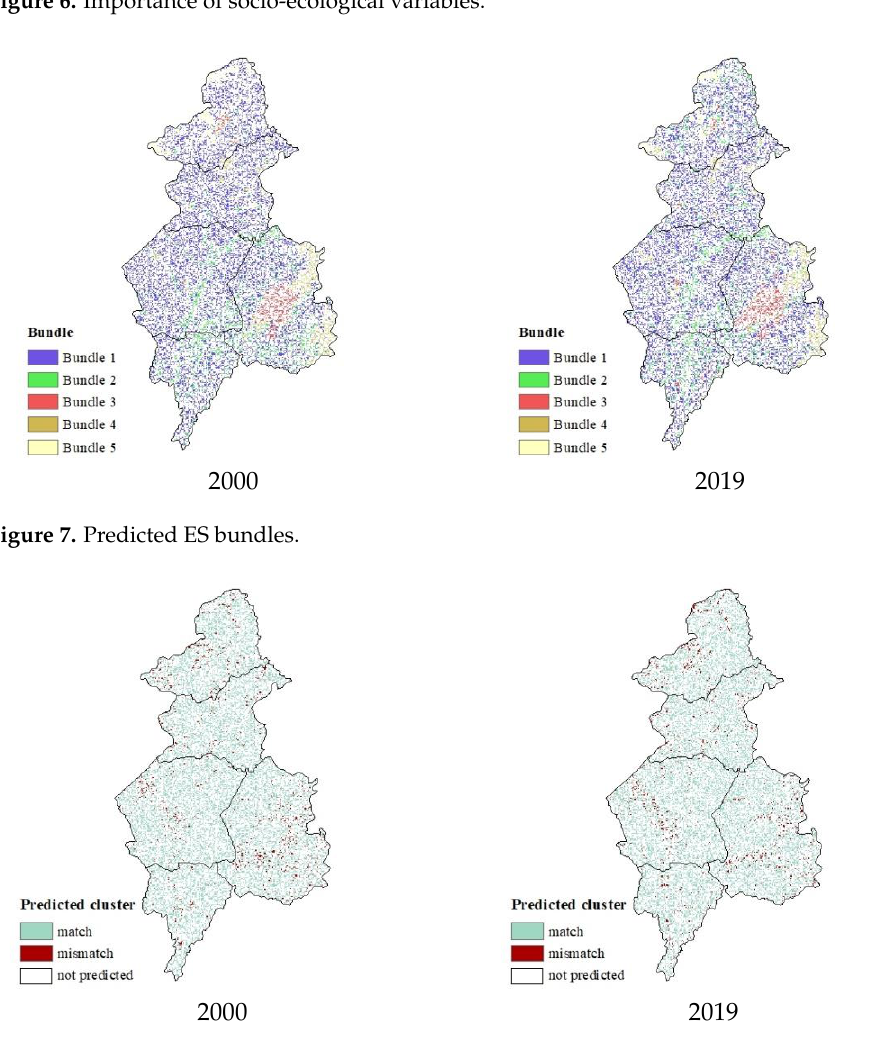
Figure 8. Accuracy of predicted ES bundles.